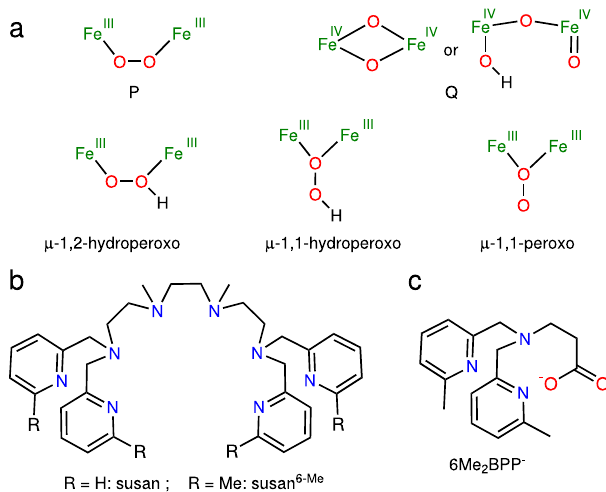
Fig. 1 Structural formula. a Supposed intermediates in non-heme diiron enzymes. b The dinucleating ligands susan and susan 6-Me . c The mononucleating ligand 6Me 2 BPP -